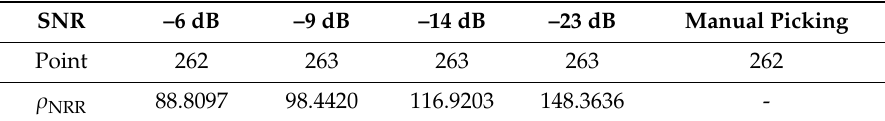
Figure 10. Noisy PD signals with varying SNR values based on the signal in Figure 8b: ( a , c , e ); Corresponding time-varying kurtosis curves of the PD signals extracted from the noisy PD signals using the proposed CEEMDAN-Hankel-SVD method: ( b , d , f ). Table 2. The number of PD signals picked up by different signal-to-noise ratios.